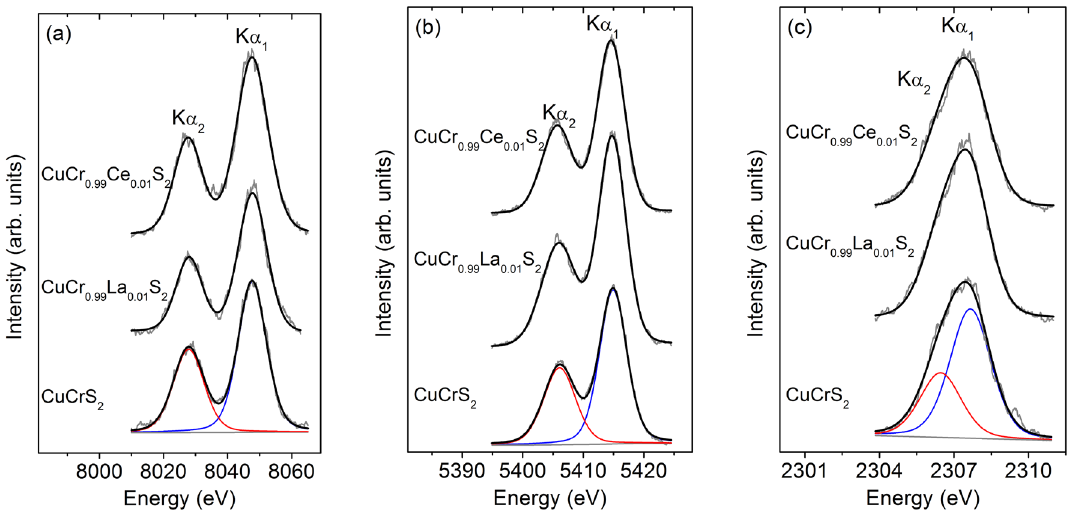
Figure 2. XES Kα 1,2 -spectra of CuCrS 2 -matrix and CuCr 0.99 Ln 0.01 S 2 (Ln = La, Ce) solid solutions: ( a ) Cu Kα 1,2 -, ( b ) Cr Kα 1,2 - and ( c ) S Kα 1,2 (Table 2). Taking into account the measurement accuracy, the Cr Kα 1 -maxima energy position values correlate with one for Cr 2 O 3 reference compound and typical for Cr 3+13 . The absence of the significant chemical shifts of Cr( 2p )- and Cr Kα -lines indicates that cationic substitution does not significantly affect the chromium atomic charge. The Cr Kα -line shape fact indicates the absence of the additional chromium oxidation states. Note, that 2p to 1 s core level electron transition, corresponding to XES Kα -lines, occurs in the Coulomb field created by surrounding atoms of the system. Thus, the position of the XES line depends only on the electron density local- ized on the investigated atom. The potential from the chemical surrounding does not affect the XES lines energy position. Hence, the additional components arising in Cr( 2p )-region from the Cr 3+ oxidation forms could not be resolved in Cr Kα -region 13 . Figure 1c plots the XPS S(2 p 3/2,1/2 )-lines of CuCrS 2 -matrix and lanthanide-substituted solid solutions. Table 1 lists the experimental BE values of S(2 p 3/2 )-lines. The S(2 p )-line is a superposition of two components (S(2 p 1/2 ) and S(2 p 3/2 )) arising from the spin–orbit coupling of S2 p core-level. The experimental S(2 p )-region presents a superposition of lines arising from the several nonequivalent groups containing different types of sulfur atoms (denoted as I , II and III in Fig. 1c). The first group ( I ) includes the sulfur atoms in the composition of the CuCrS 2 -matrix and lanthanide-doped solid solutions (Table 1). The energy position of S( 2p 3/2 )-line (BE ~ 161.5 eV) corresponds to S 2− oxidation state and is typical for the transition metal sulfides (BE(CuFeS 2 ) ≈161.5 eV; BE(Cu 2 S) ≈161.8 eV) 19,24,25 . The second group of S(2 p )-lines ( II ) with BE ~ 163 eV is assumed to include the elemental sulfur (BE ≈ 163.5 eV) on the powder surface. The presence of the “surface” elemental sulfur is typical for the natural and synthesized sulfide materials 26 . The last group of S(2 p )-lines ( III ) with BE ~ 168.2 eV is assumed to include the oxygen-containing compounds of sulfur on the powder surface (BE(CuSO 4 ) ≈169.6 eV; BE(C 12 H 8 SO 2 ) ≈168.2 eV, BE ((NH 4 ) 2 SO 4 ) ≈168.3 eV; BE(SO(CH correspond to divalent sulfur and correlates with one for KSCN reference compound containing S 2− (Table 2). The S Kα 1,2 -line shape and the energy position allow one to conclude that additional groups of sulfur atoms are localized in the near-surface layers. Thus, the absence of the significant chemical shifts of the S(2 p )- and S K α-lines allow one to conclude that cationic substitution of CuCrS 2 -matrix with lanthanide atoms does not significantly affect the sulfur atoms oxidation state. The XPS lines of lanthanides (La and Ce) are presented in Fig. 1d. The BE values of Ln(3 d 5/2 )-lines are listed in Table 1. The Ln(3 d )-region exhibits the main peak ( I ) accompanied with a satellite line ( II ) arising due to the multi-electron processes (multiplet structure) 30 . The La(3 d 5/2 )-line is unresolved peak with structure typical for La 3+ (two components with the similar intensity) 24 . The obtained La(3 d 5/2 ) BE value equal to ~ 835.4 eV cor- responds to La 3+ (BE (La 2 O 3 ) ≈835 eV) 24,25 . The multiplet splitting (MS) between the main and the satellite lines in the Ln(3d)-spectra allows one to identify the Ln oxidation state. The measured MS value of La(3d5/2)-line is equal to 3.2 eV. The typical MS value for La 3+ compounds lies within the range of ~ 3.5–4.6 eV 25 . Thus, one can conclude that lanthanum atoms in the composition of CuCr 0.99 La 0.01 S 2 are trivalent. In contrast to the lanthanum, the cerium could exhibit a few stable oxidation forms (Ce 3+ or Ce 4+ ). It should be noted that as it was reported previously for vanadium-doped solid solutions CuCr 1-x V x S 2 (x < 0.15), the vanadium atoms were found to be in V 4+ oxidation state 13 . Hence, the cerium oxidation state is of special interest. The Ce(3 d 5/2 )-line has a structure similar as those for La(3 d 5/2 )-line. The BE values corresponding to the different oxidation forms of the cerium atoms lies almost in the same energy region. For instance, the BE value for Ce 4+ (BE(Ce 4+ ) ≈882–882.7 eV) is slightly higher than for Ce 3+ (BE(Ce 3+ ) ≈880–881.5 eV) 24,25,31,32 . The measured BE value of Ce(3 d 5/2 )-line for cerium-doped solid solution CuCr 0.99 Ce 0.01 S 2 is equal to ~ 882.1 eV. At the same time, the MS values for Ce 4+ and Ce 3+ are reported to have more significant